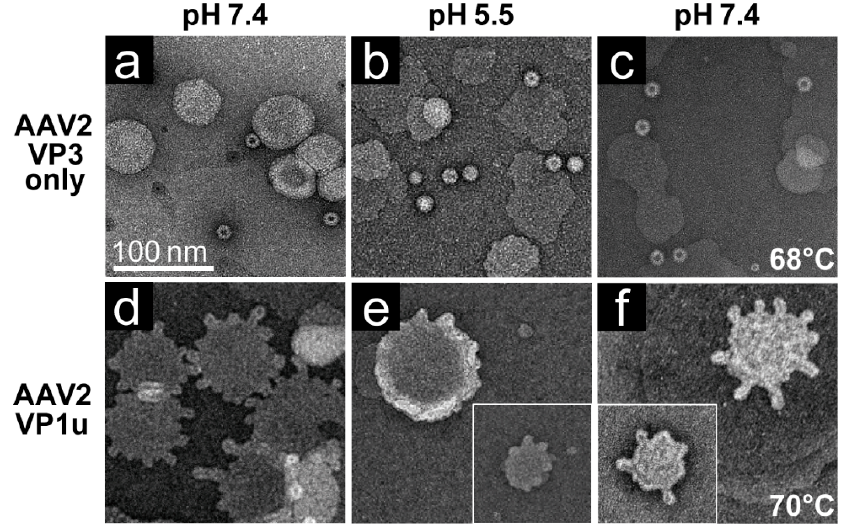
Figure 7. POPC liposome modification in the presence of AAV. Liposomes in presence of ( a ) AAV2 VP3 only VLPs at pH 7.4, ( b ) at pH 5.5, and ( c ) in presence of AAV2 VP3 only VLPs that were heat-shocked prior to addition to liposomes. POPC liposomes in presence of the AAV2 VP1u polypeptide at ( d ) pH 7.4, ( e ) at pH 5.5, and ( f ) after heat-shock to 70 °C prior to addition to liposomes. Bleb formation